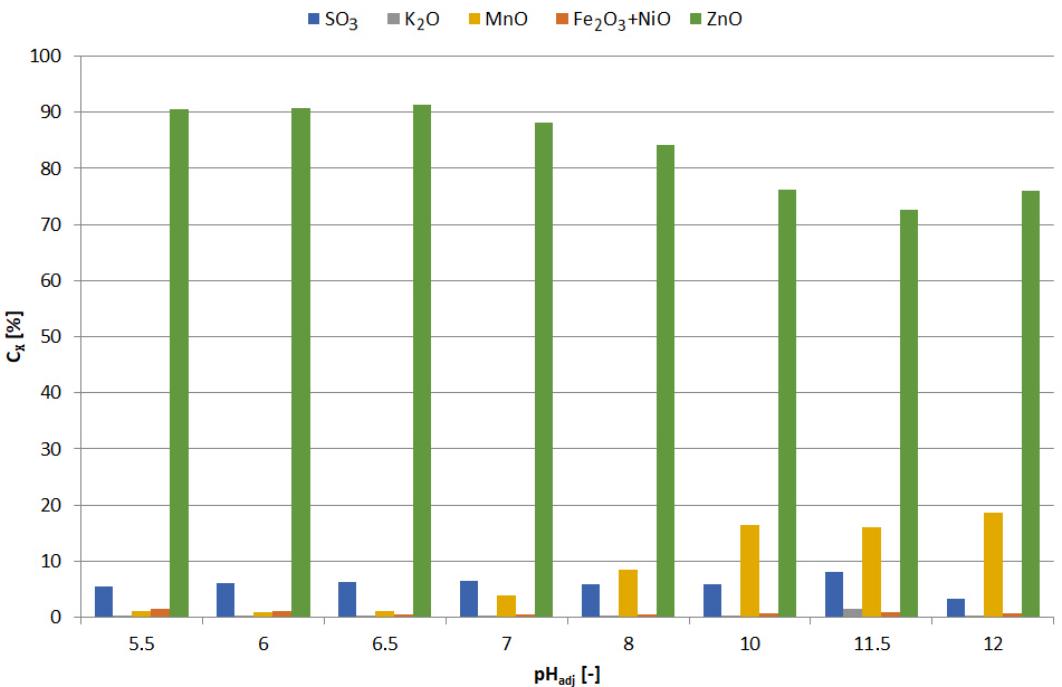
Figure 13. Effect of adjusted pH (pH adj ) on chemical composition of precipitates as a result of precipitation by using NaOH from selective leaching solution.